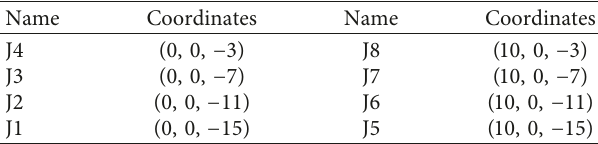
Table 5: Information of monitoring